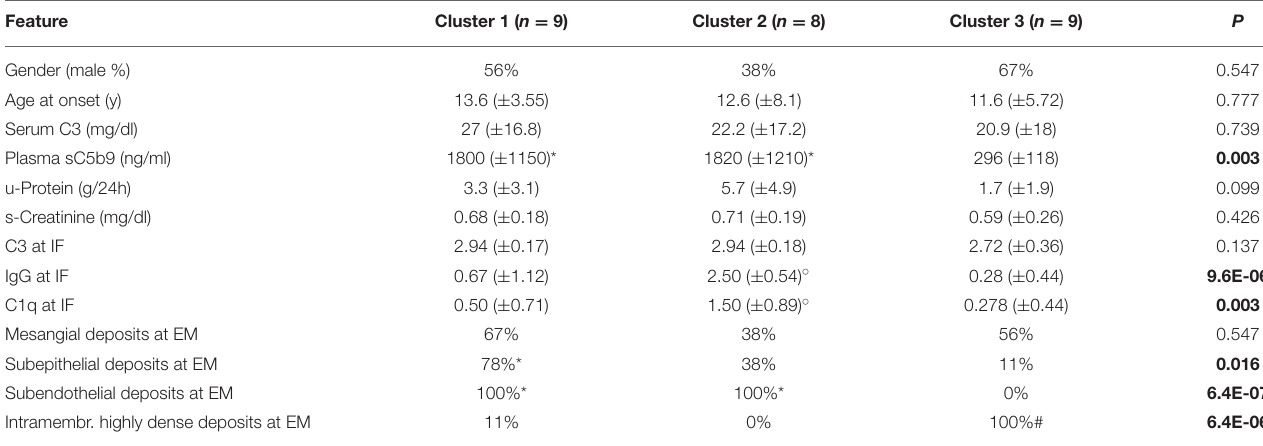
TABLE 4 | Comparison of clinical, and biochemical parameters at onset and histology features between clusters.